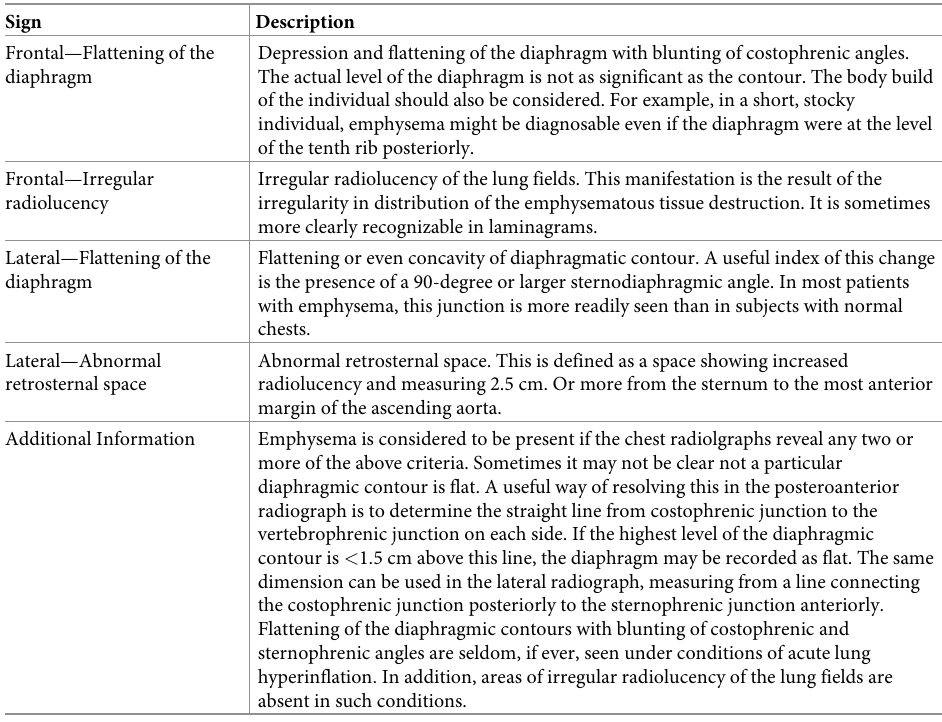
Table 1. The four signs of emphysema as described by Sutinen et al. [18]. Sign Description Frontal—Flattening of the Depression and flattening of the diaphragm with blunting of costophrenic angles. diaphragm The actual level of the diaphragm is not as significant as the contour. The body